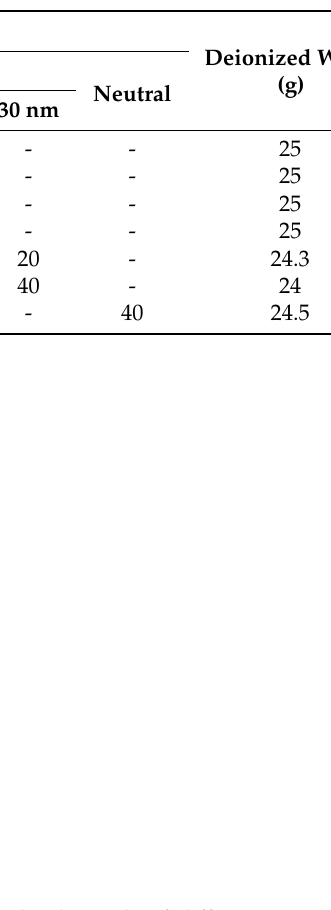
Table 3. Coatings with silica sols of different particle sizes and acid base.